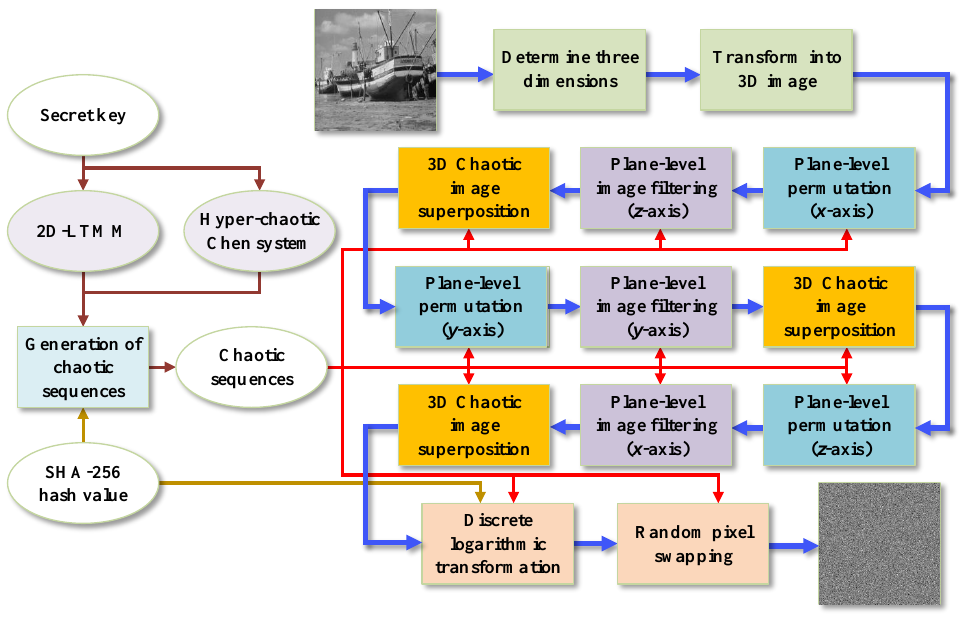
Figure 2. Flowchat of